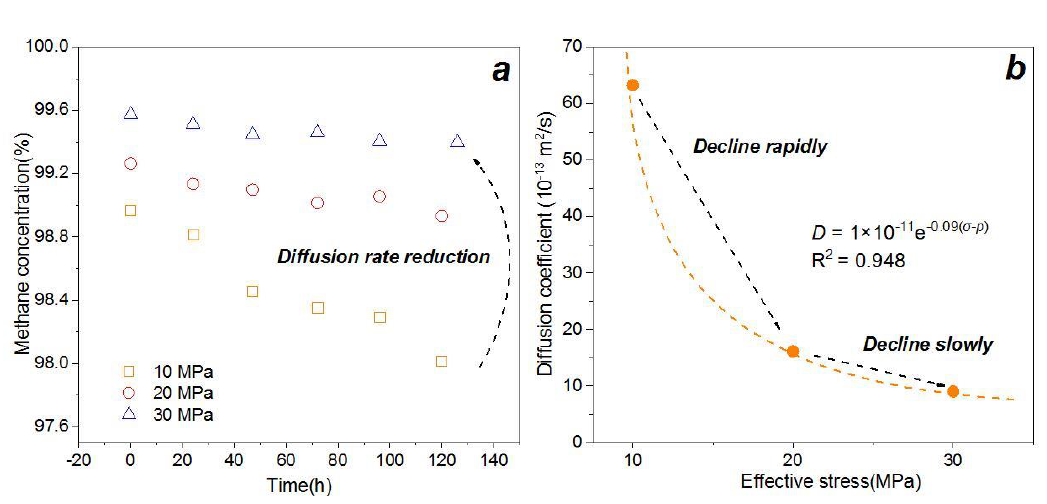
Figure 10. Shale diffusion test results. ( a ) Methane gas concentration curve under different confining Figure 10. Shale di ff usion test results. ( a ) Methane gas concentration curve under di ff erent confining pressures. ( b ) Variation in the shale diffusion coefficient with the confining pressure. pressures. ( b ) Variation in the shale di ff usion coe ffi cient with the confining